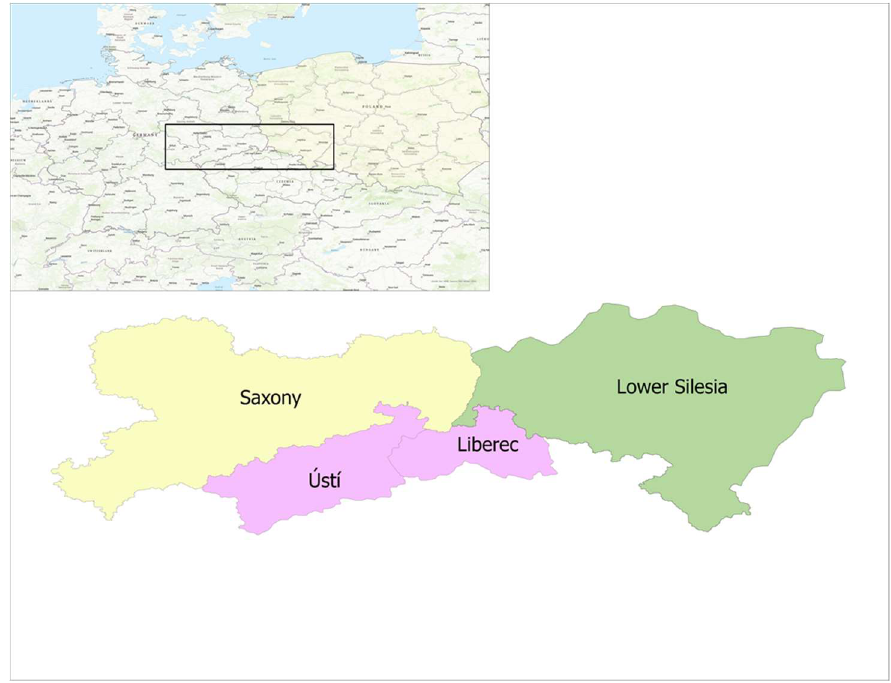
Figure 1. Map of Targeted Regions in the Northern Czech Republic, Saxony and Lower Silesia